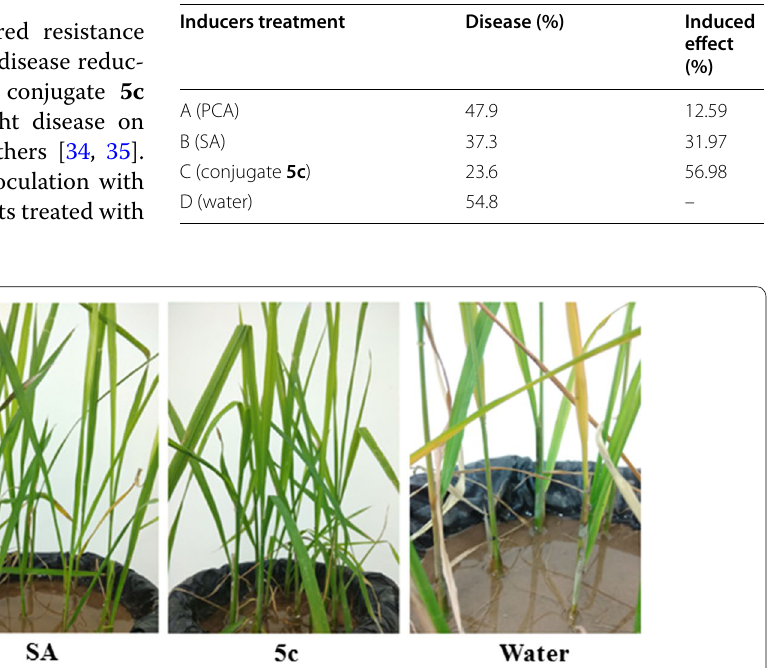
Table 3 Induced resistance of rice to rice sheath